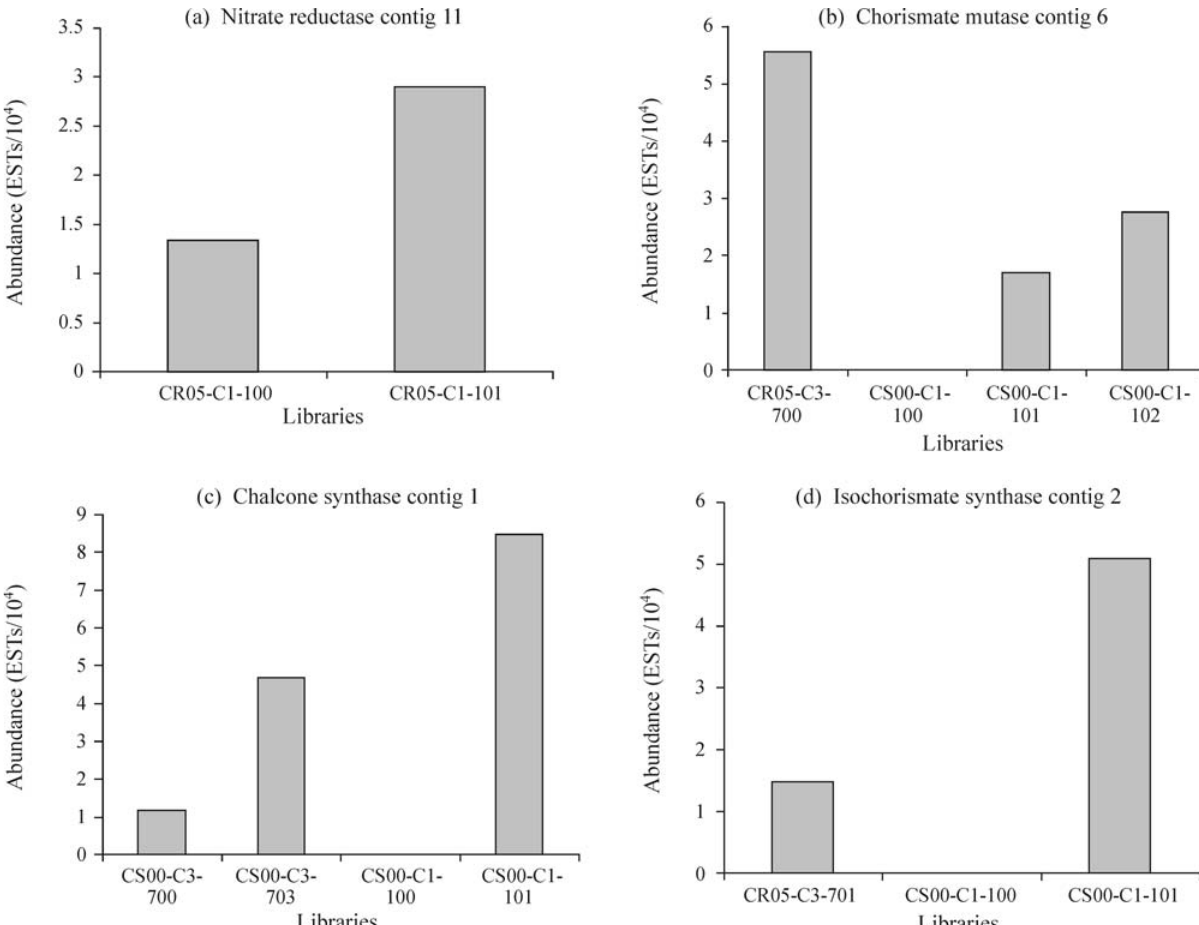
Figure 1 - Transformed data representing the relative abundance of EST by library, expressed in 10 4 reads: (a) Nitrate reductase contig 11, (b) chorismate mutase contig 6, (c) chalcone synthase contig 1, (d) isochorismate synthase contig 2. Code of the libraries: CS: Citrus sinensis ; CR: Citrus reticulata ; C1: leafcDNA;C3:fruitcDNA;100:non-infectedmaterial;101:infectedwith Xylellafastidiosa ;102:30daysafter X.fastidiosa infection;700:stadium1of the fruit; 701: stadium 2 of the fruit; 703 stadium 4 of the fruit.